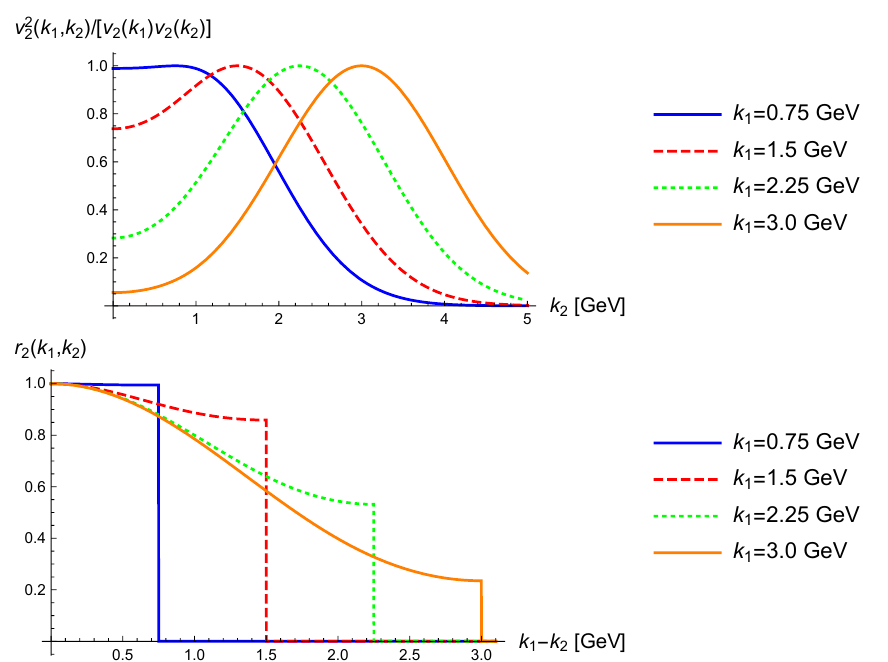
Figure 7 . Upper panel: illustration of factorization breaking v 2 Lower panel: the corresponding factorization ratio r 2 ( k 1 ; k 2 ) as de(cid:12)ned in equation (7.1), plotted for selected ‘trigger’ momenta k 1 against the relative momentum di(cid:11)erence k 1 (cid:0) k 2 .